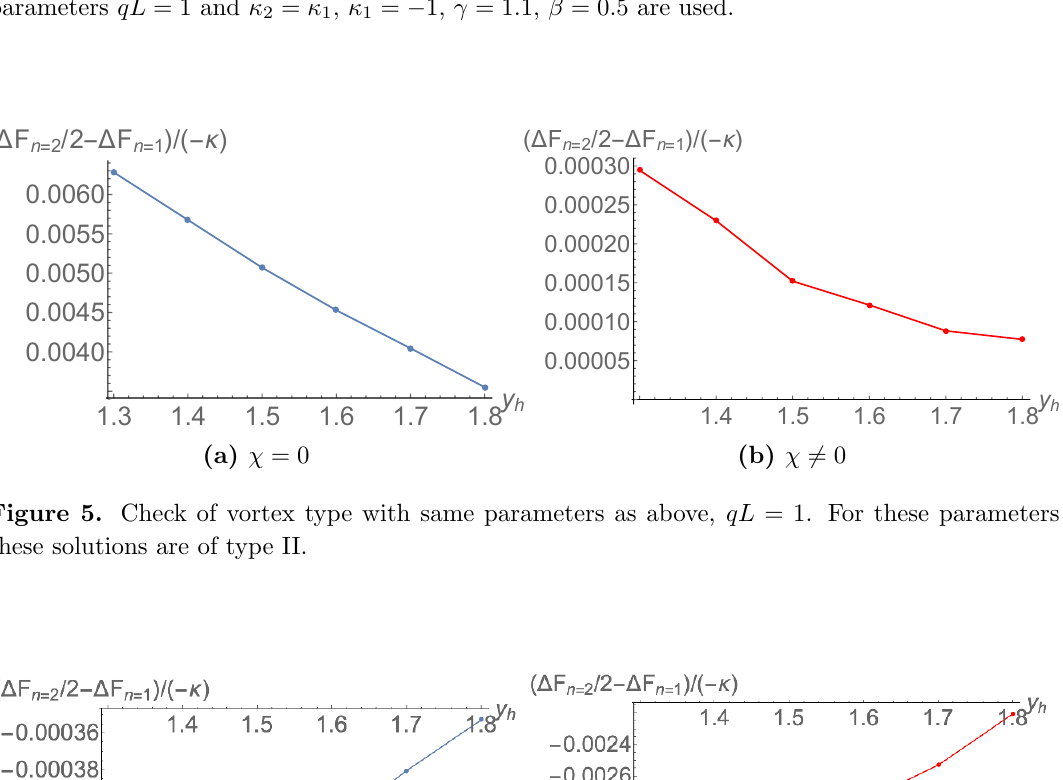
Figure 4. Di(cid:11)erence in free energy between solutions with the (cid:31) condensate and those without, as a function of y h (or temperature). A negative result indicates the phase with (cid:31) is preferred. The parameters qL = 1 and (cid:20) 2 = (cid:20) 1 , (cid:20) 1 = (cid:0) 1, (cid:13) = 1 : 1, (cid:12) = 0 : 5 are used.